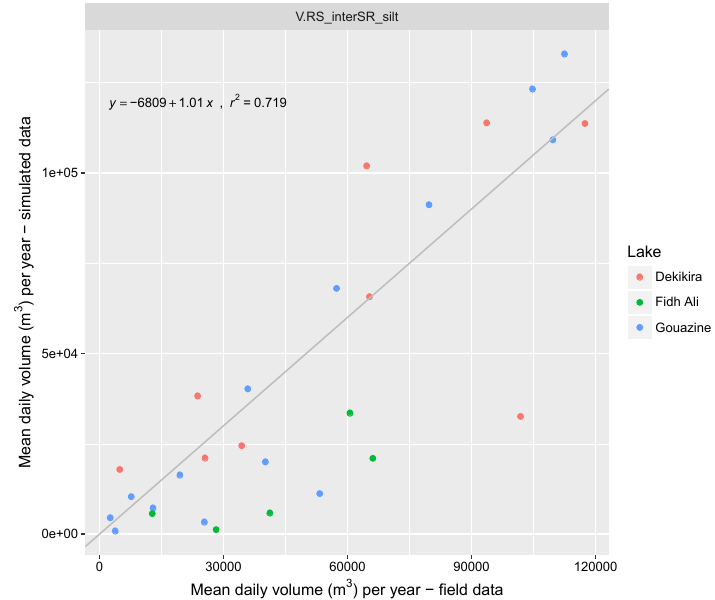
Figure 13. Correlation on mean annual volumes for three lakes between field data and remote sensing data using the power relation adapted for